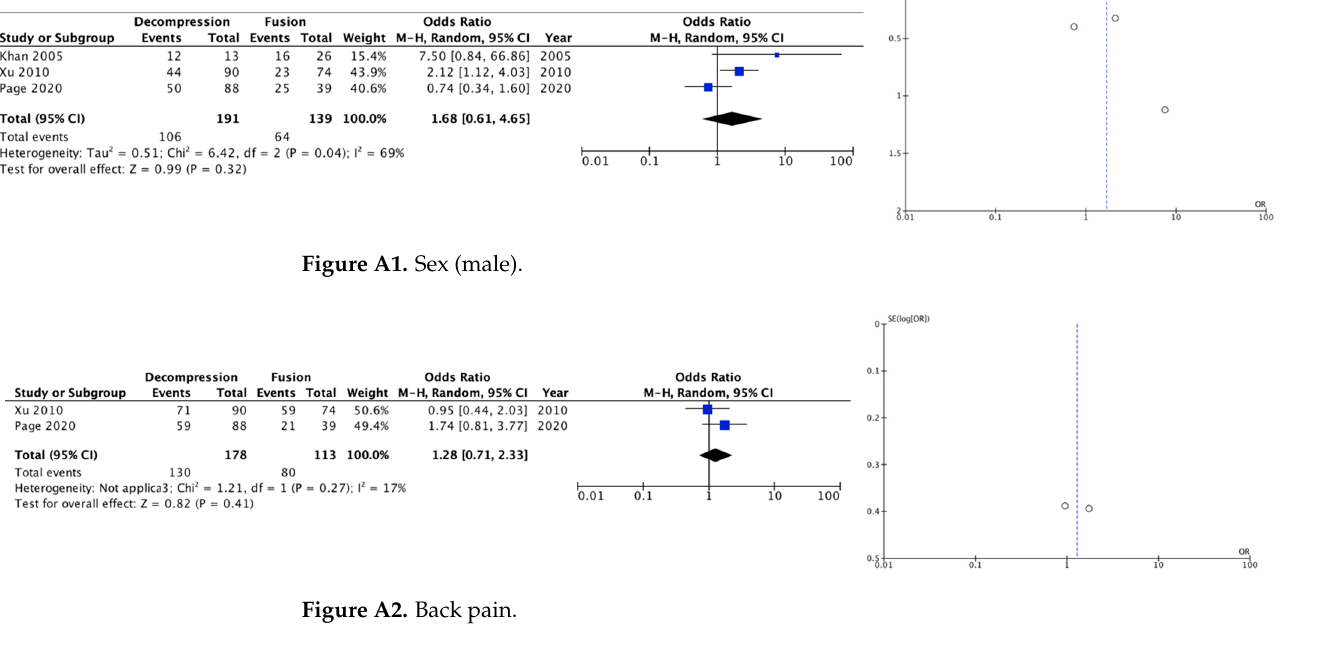
Figure A3. Radiculopathy.